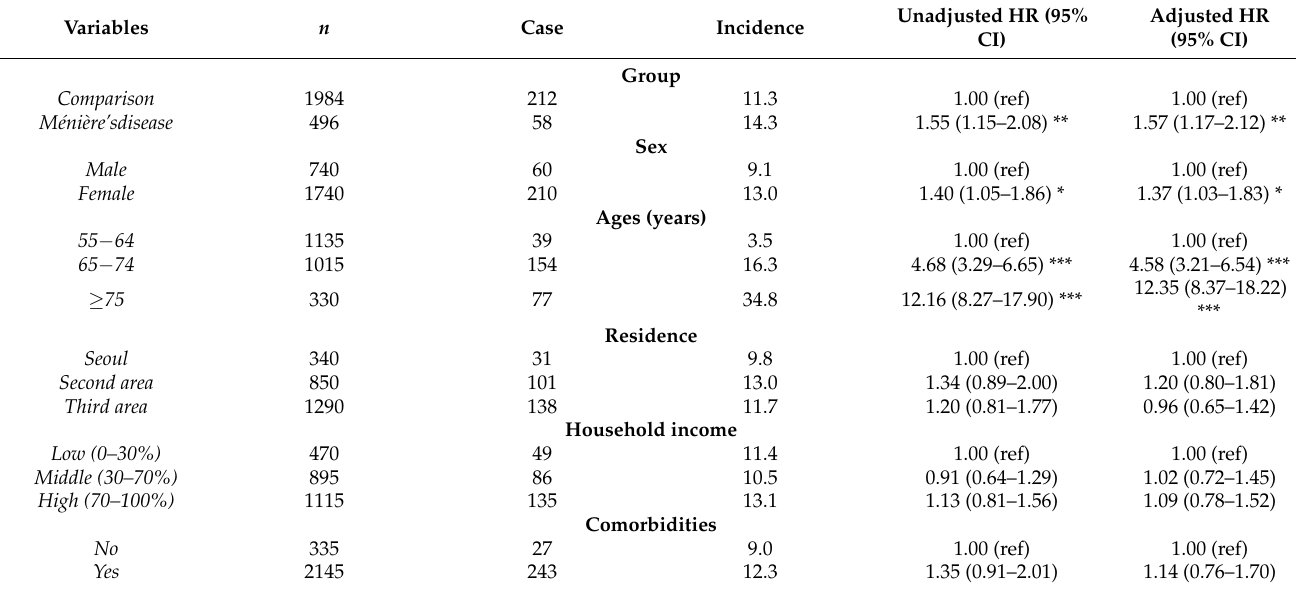
Table 4. Incidence per 1000 person–years and HR (95% CIs) of dementia between comparison